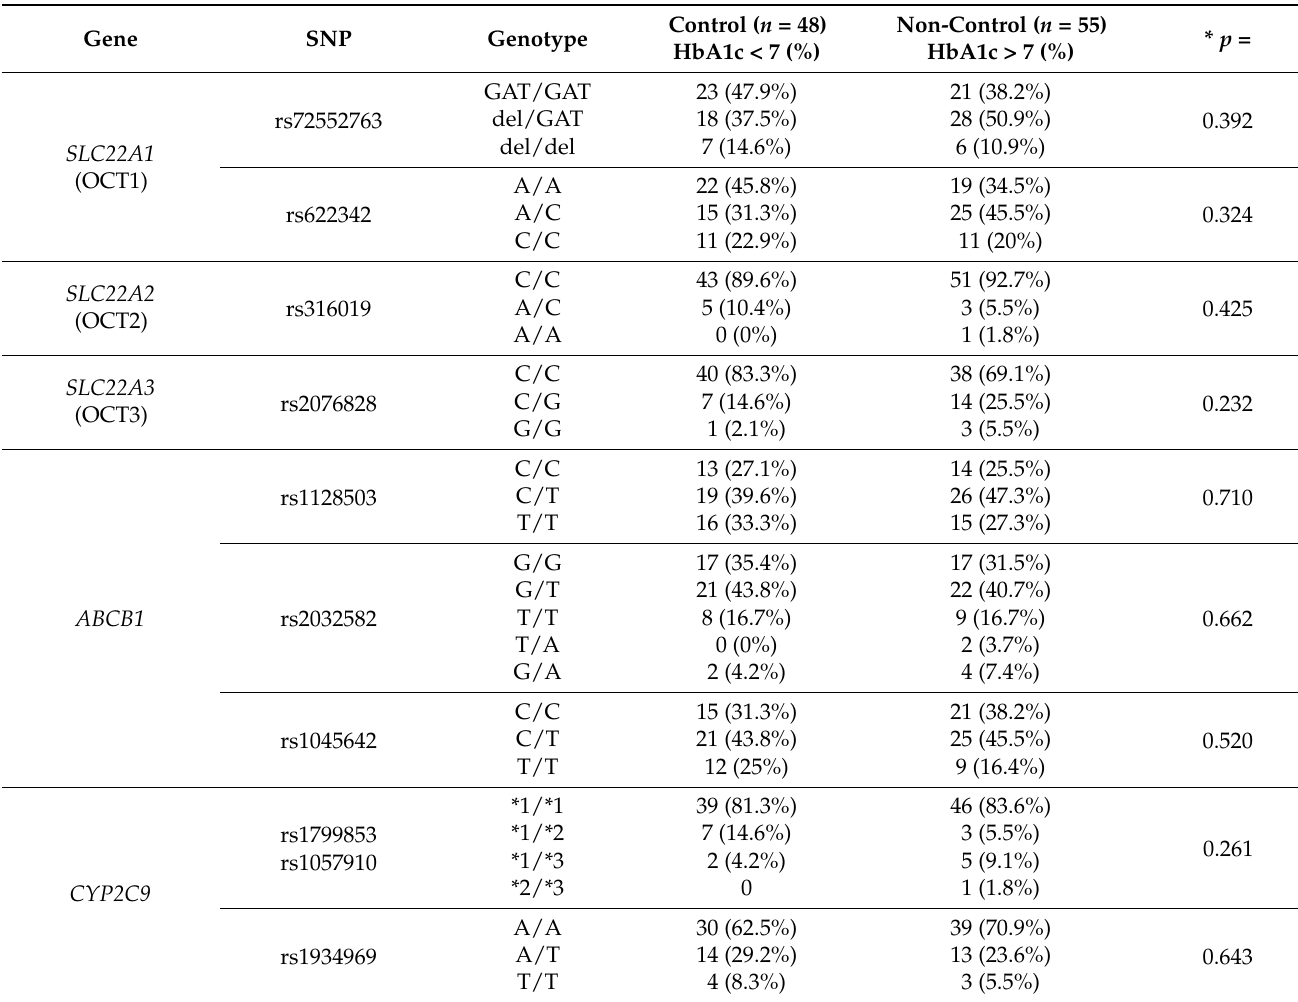
Table 3. Therapeutic efficacy by studying SNP and DMT2 patients’